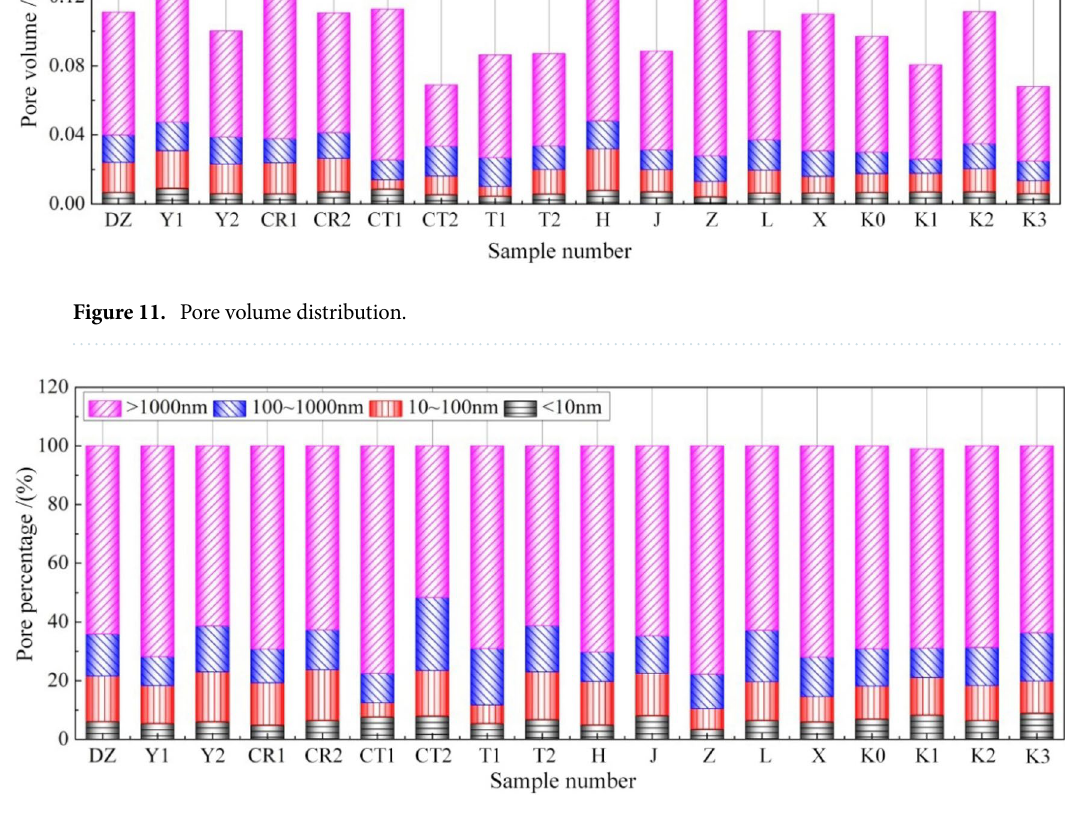
Figure 12. Pore percentage